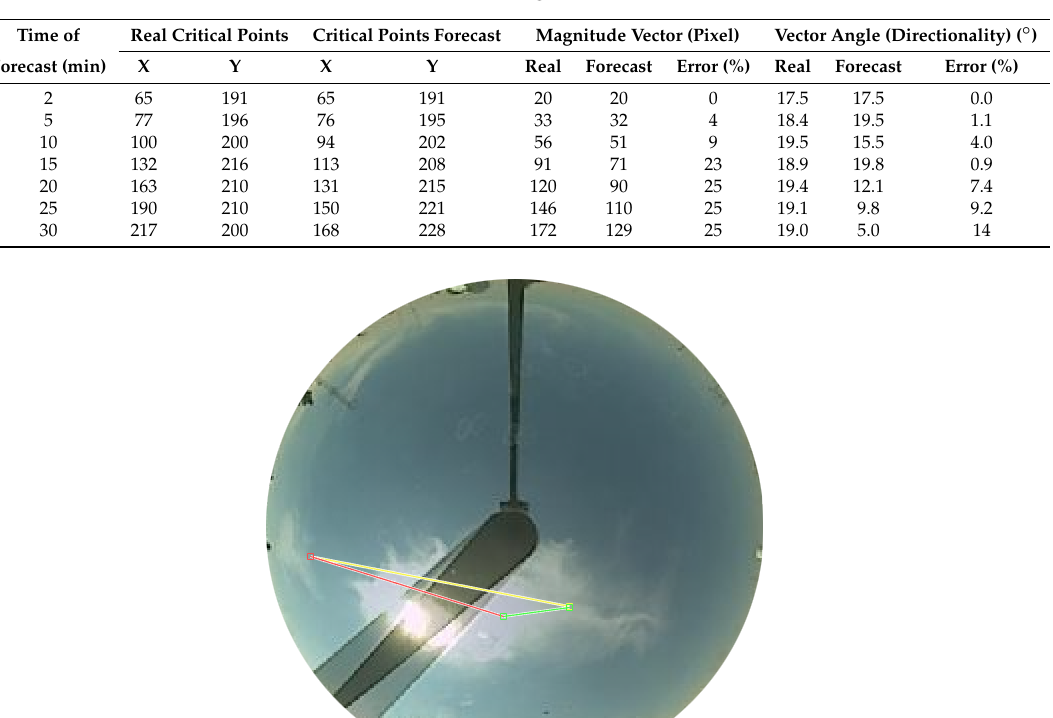
Table 1. Results tracking cloud movement.